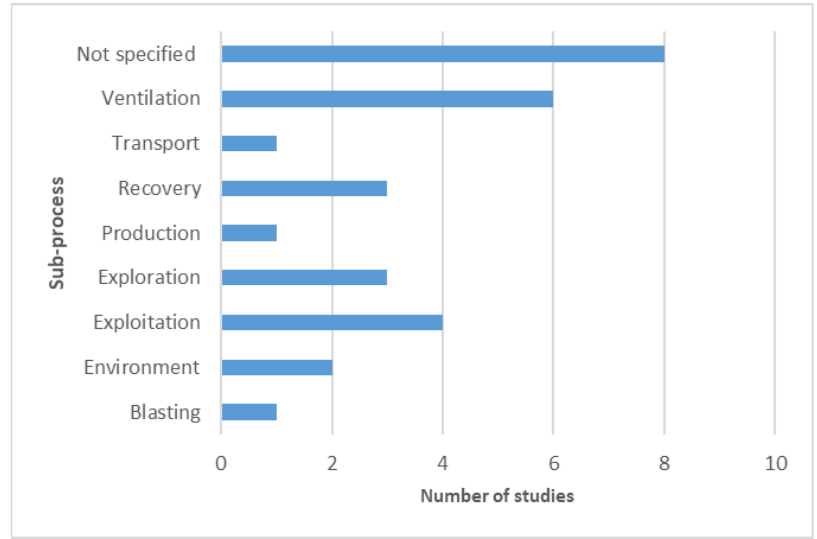
Figure 4. Study distribution per sub-process.